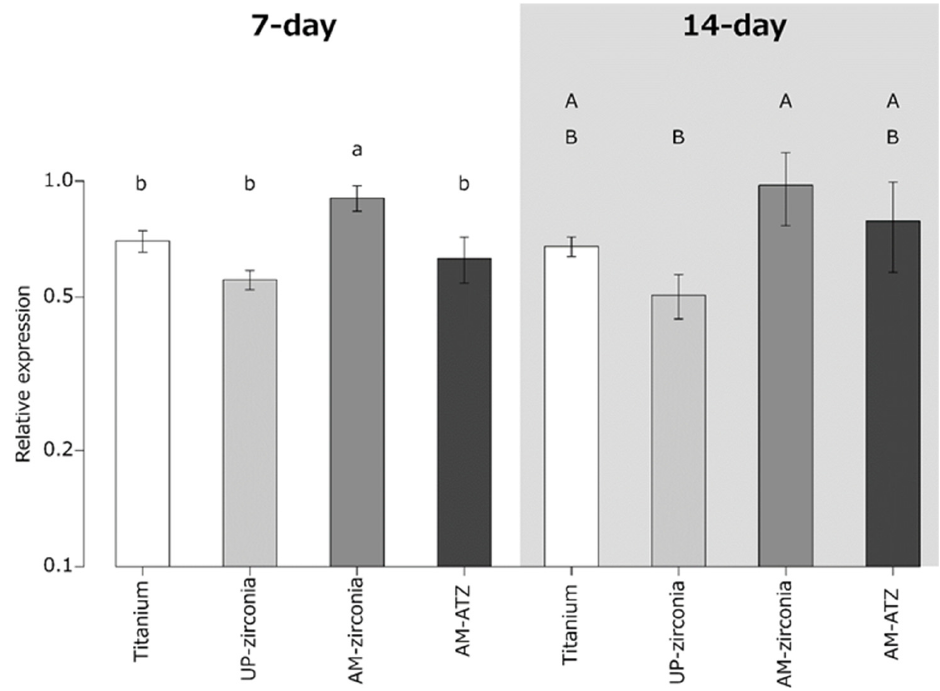
Figure 5. Gene expression of type 1 collagen on each material at 7 and 14 days. Identical letters indicate no statistical difference.